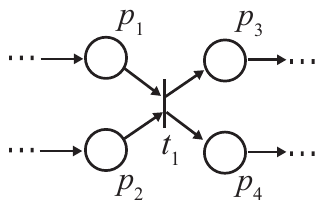
Figure 3. Synchronous